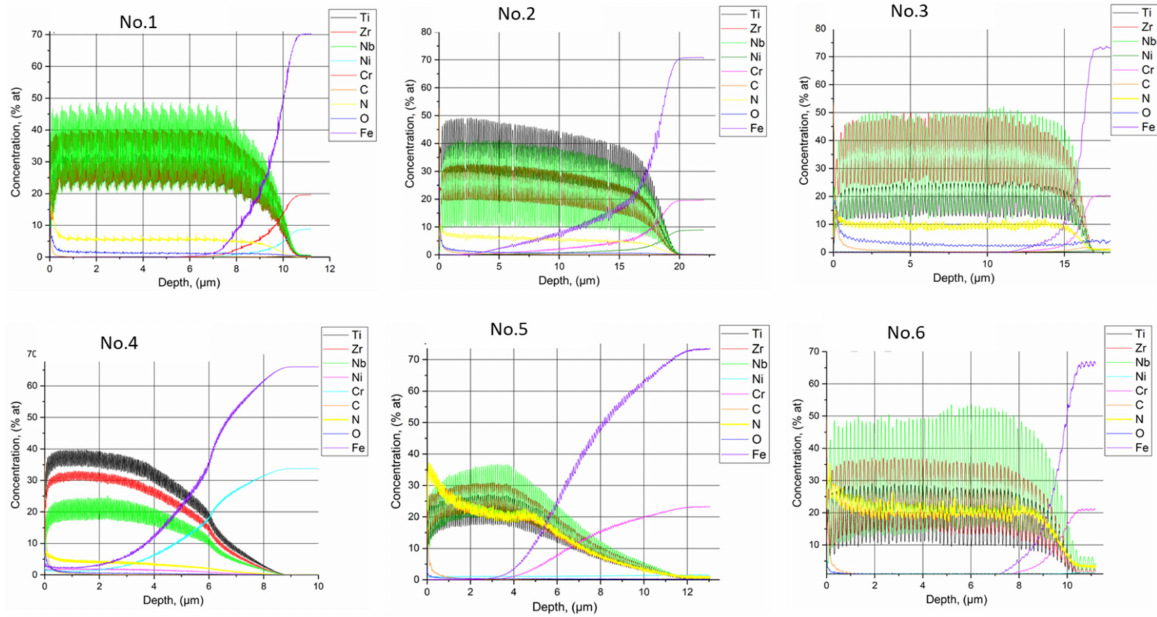
Figure 5. Distribution of elements over the thickness of (TiZrNb)N